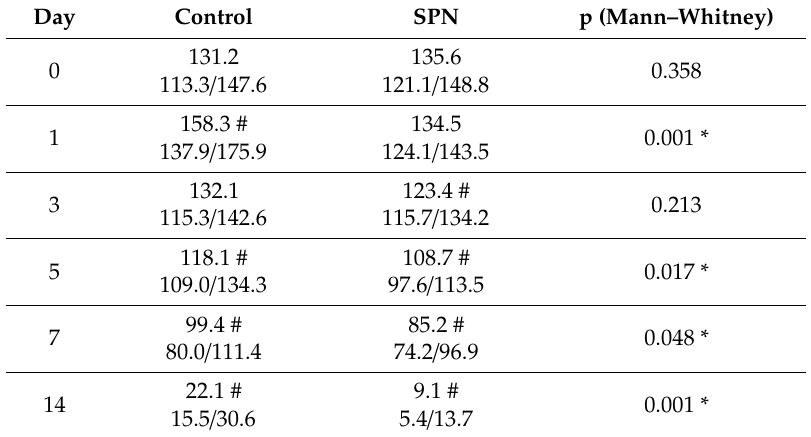
Table 1. Changes over time in the area of wounds in the control and SPN groups (mm 2